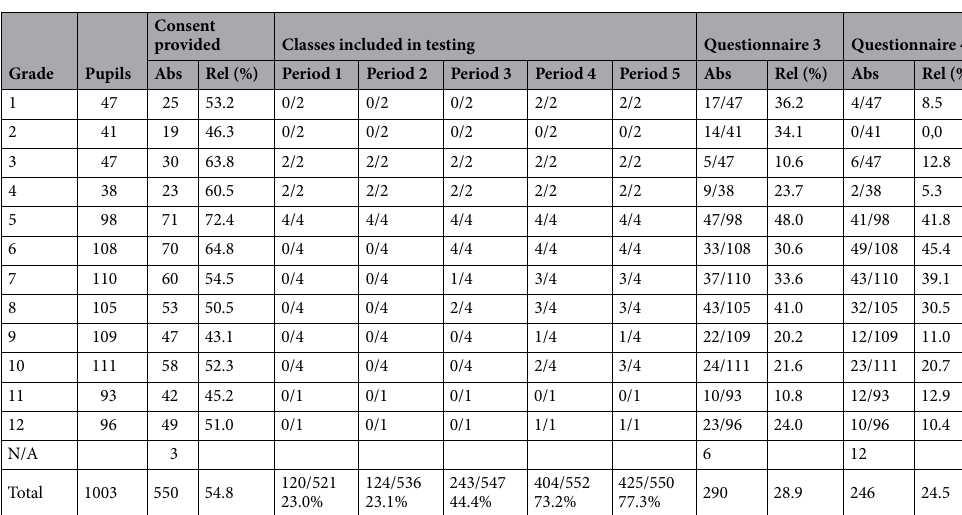
Table 1. Summary of participation rates in the testing programme and response rates to the acceptance questionnaires. “Consent provided” indicates provision of written, informed consent for inclusion in the testing programme. “Classes included in testing” indicates that the minimum positive response rate threshold was reached, enabling inclusion of the class in the testing programme. Questionnaires 3 and 4 were distributed to all families, irrespective of participation in the testing programme. (Q1 and Q2 were employed as a part of the testing programme to select participants with an increased risk of infection.) Period 1: 2 to 14 December, 2021; Period 2: 1 (primary school) or 8 (secondary school) to 16 March, 2021; Period 3: 17 to 26 March, 2021; Period 4: 6 April to May, 2021; Period 5: 26 May to 16 June, 2021. “abs” = absolute (numbers of pupils). “rel” = relative (to the number of pupils in the class).